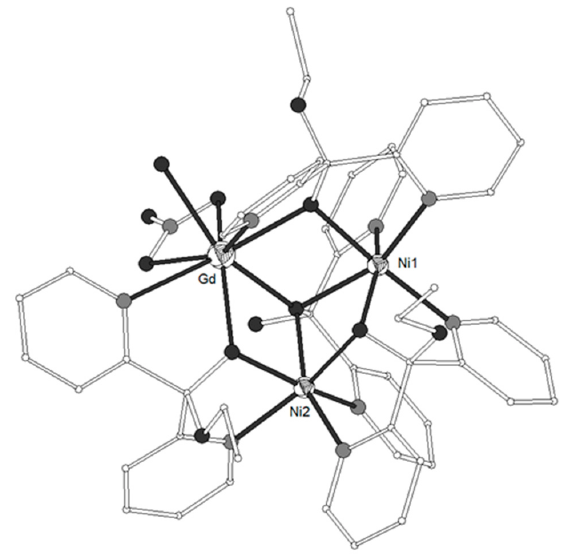
Figure 15. The molecular structure of the dication complex [Ni 2 (L 29 ’) 3 (L 29 ”)Gd(NO 3 )(H 2 O)] 2 + 141 . Color code: Gd large octant, Ni small octant, N light grey, O dark grey, C open small, S open large [50,51].